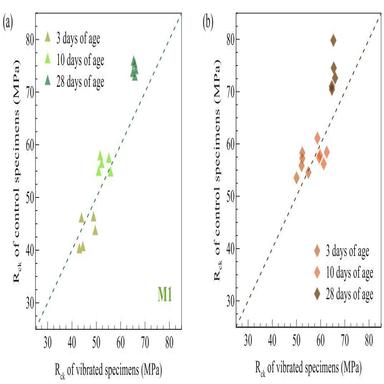
Compressive strength Rck of vibrated vs control specimens: (a) M1 and (b) M2 mortar.